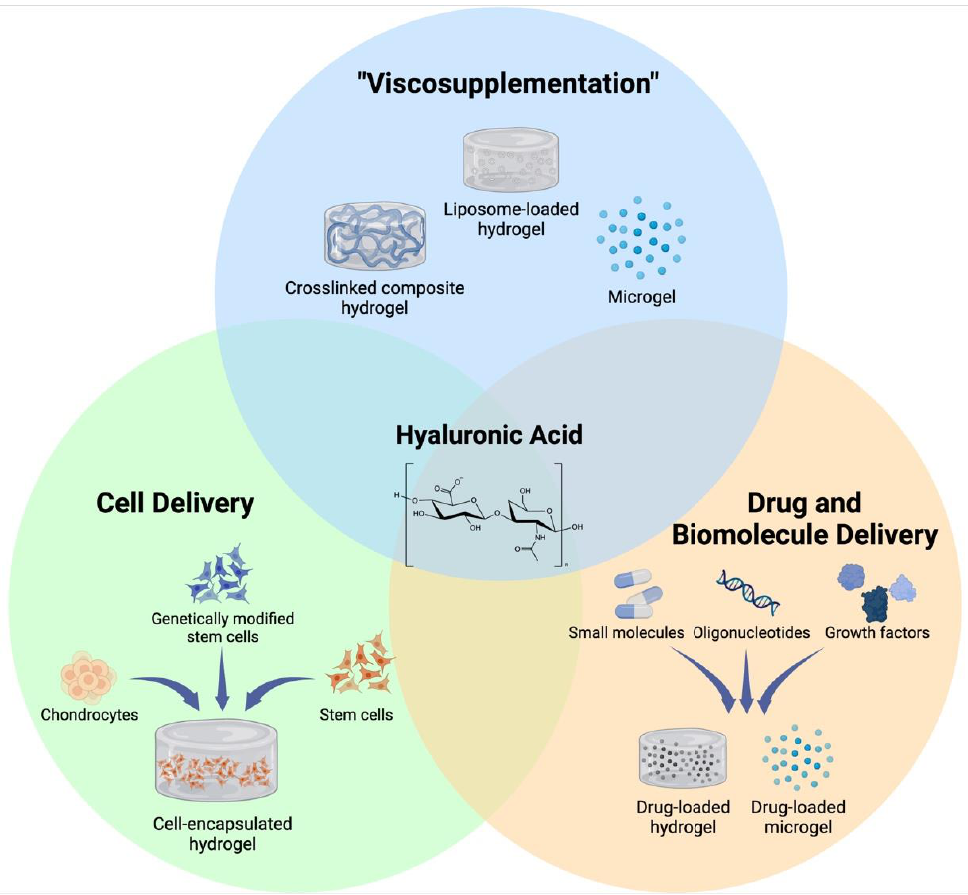
Figure 1. Different applications of HA-based hydrogels. Ease of chemical modification and excellent biocompatibility of HA allows for development of various HA-based hydrogels that are designed to serve distinct purposes for treatment of OA. Created with BioRender.com (accessed on 5 June 2022).